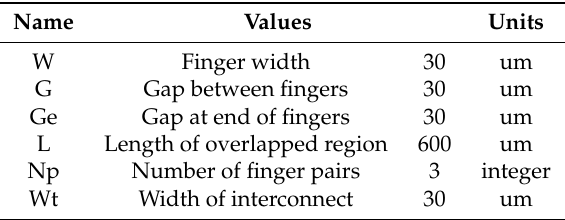
Figure 7. Geometry layout of the microstrip interdigital capacitor. Table 4. Parameters of microstrip interdigital capacitor.